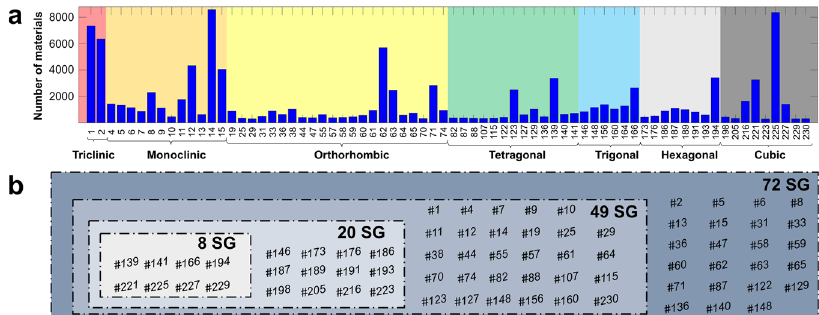
Fig. 2 Population distribution of the diffraction pattern dataset. a The number of materials in each space group, along with the crystal system information. The background colors represent seven types of crystal systems: triclinic in red, monoclinic in orange, orthorhombic in yellow, tetragonal in green, trigonal in blue, hexagonal in light gray, and cubic in dark gray. b The usage of our dataset for the